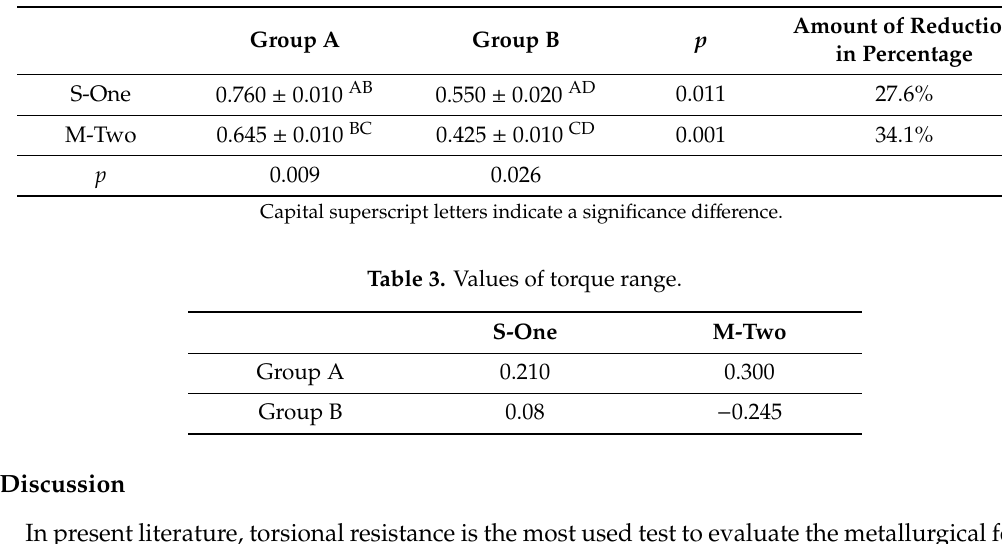
Table 2. Mean values for torque at Failure (TaF). p value was set at 0.05. Di ff erent capital superscript letters indicates significant di ff erence among the groups ( p < 0.05).